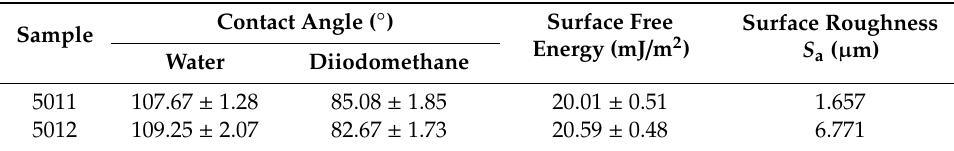
Table 3. Surface interface characteristics of coating.